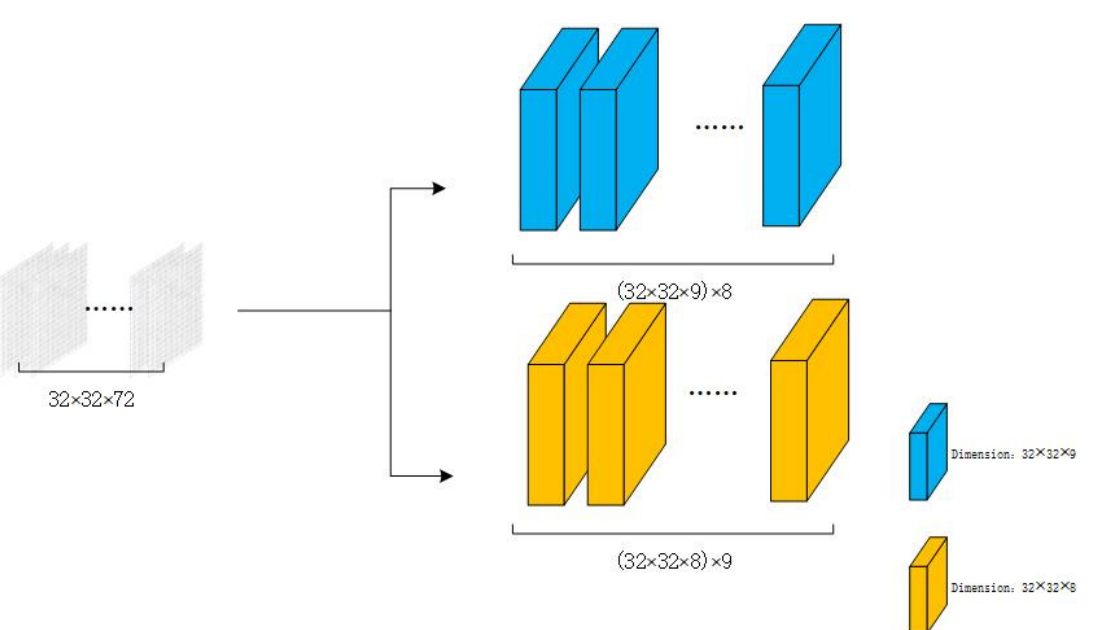
Figure 5. The preprocessing data. The dimension of 32 × 32 × 72 represents the size of the data in each dimension. Additionally, 32 × 32 is the size of a single sheet of data in space after cutting data. In addition, 72 represents the number of combinations of data recorded from different observation angles at different bands. The data we used had 8 bands and 9 observation angles, so there were 72 combinations.